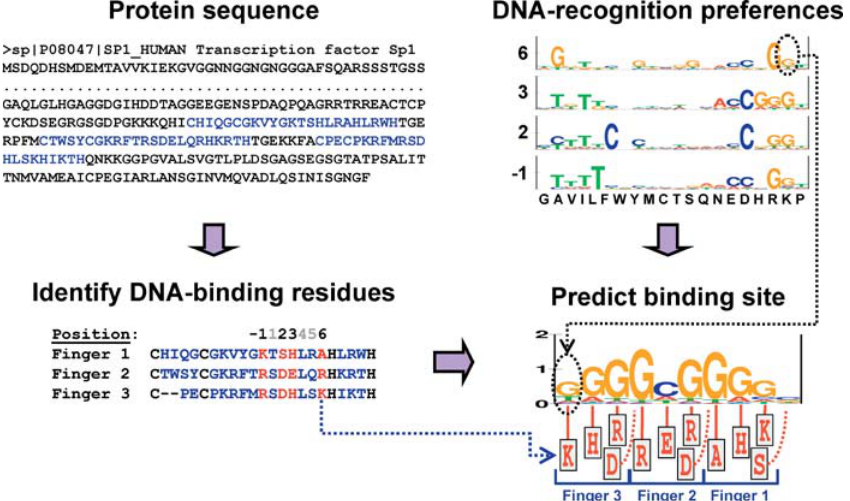
Figure 3. Predicting the DNA Binding Site Motifs of Novel Transcription Factors The protein’s DNA-binding domains are identified using the Cys 2 His 2 conserved pattern (top left). The residues at the key positions (6, 3, 2 and (cid:1) 1) of each finger (marked in red in the bottom left panel) are then assigned onto the canonical binding model (bottom right), and the sets of position-specific DNA-recognition preferences (top right panel) are used to construct a probabilistic model of the DNA binding site. For example, the lysine at the sixth position of the third finger faces the first position of the binding site (dotted blue arrow). We predict the nucleotide probabilities at this position using the appropriate recognition preferences (dotted black arrow). DOI: